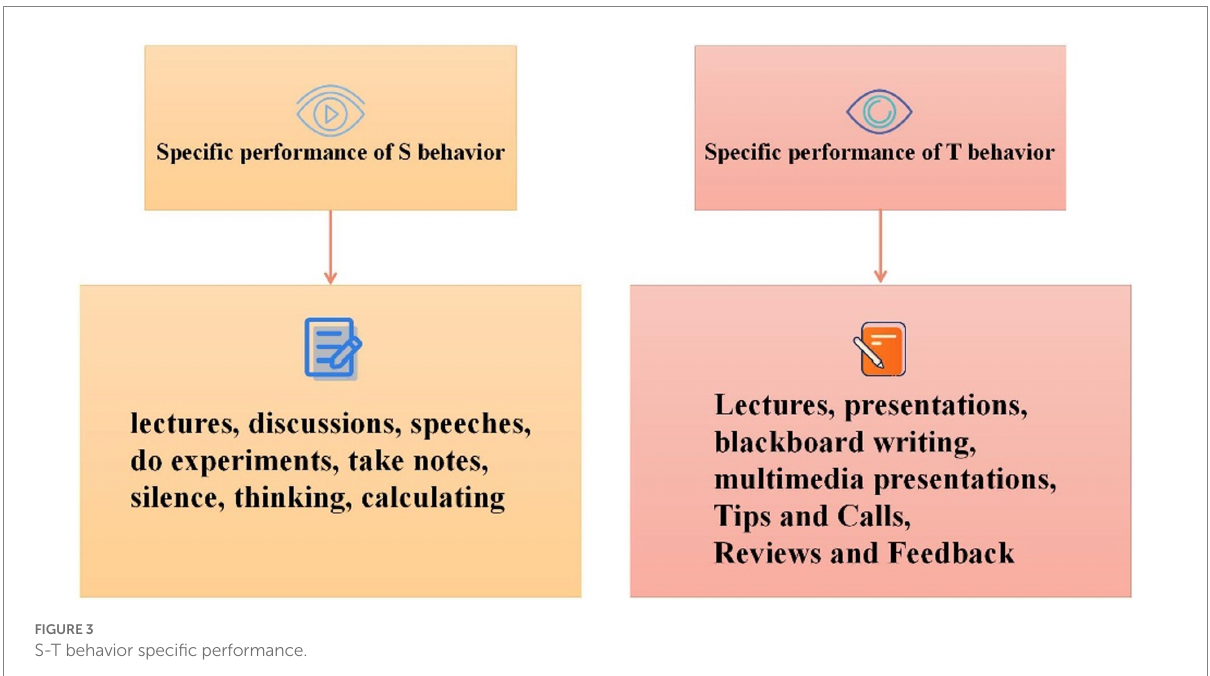
FIGURE 3 S-T behavior specific